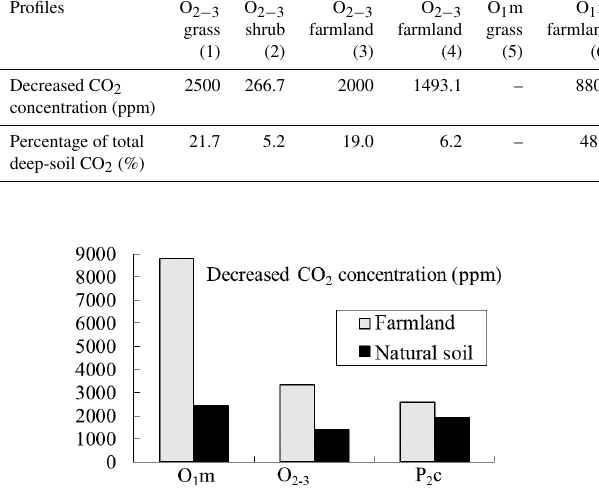
Table 5. The evaluated results of the decreased CO 2 concentration in carbonate areas caused by carbonate corrosion. Profiles